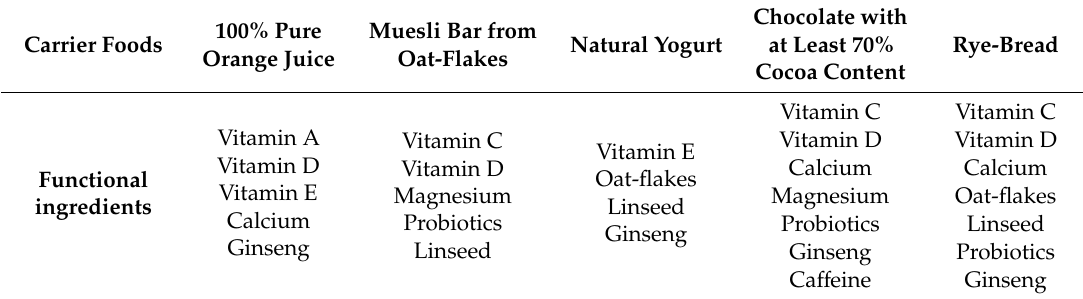
Table 2. Carrier foods and the ingredients combined with